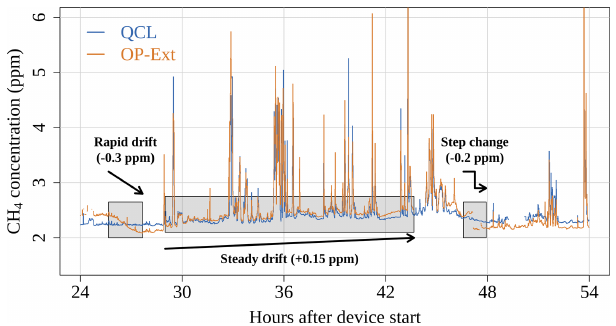
Figure 1. Time series of the average CH 4 concentration (1min av- erages) measured with the QCL and the GF3 device OP-Ext during the intercomparison campaign P16. The figure shows a 30h win- dow at the beginning of the campaign (1 to 2.5d after instrument start). Three sub-periods with specific features are marked by grey